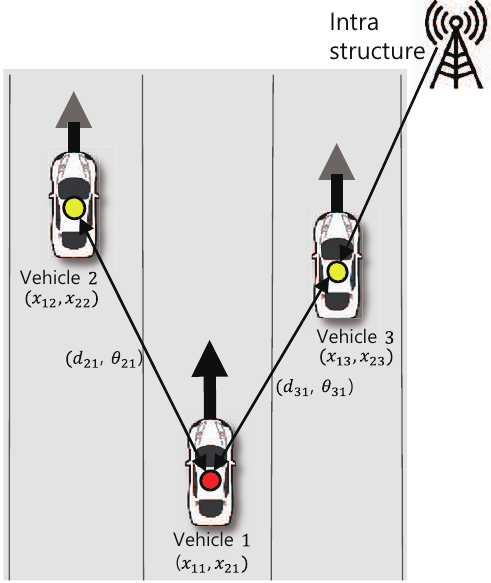
Figure 1. Cooperative localization in mm-wave vehicular